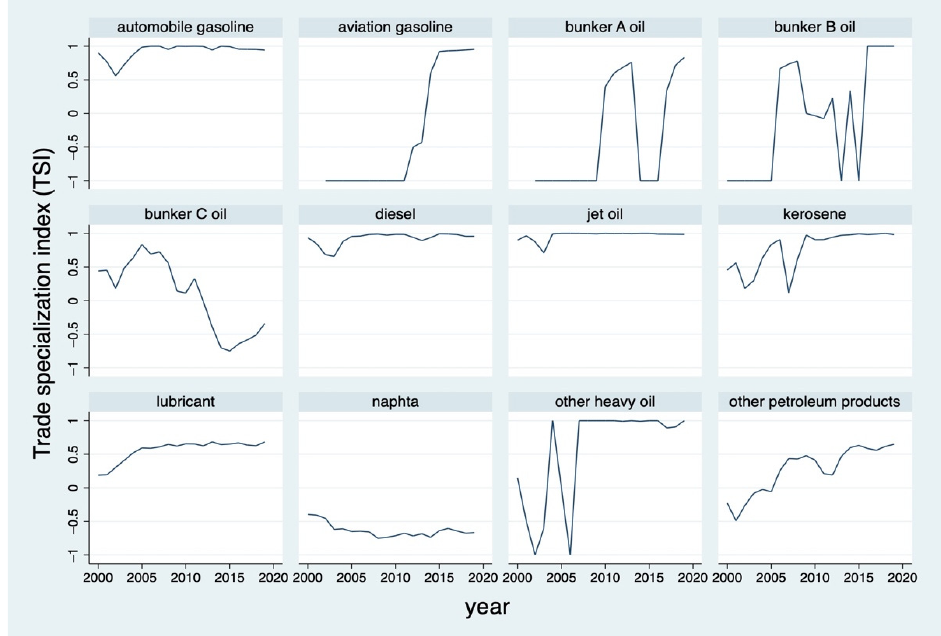
Figure 3. Trade specialization index by petroleum product.